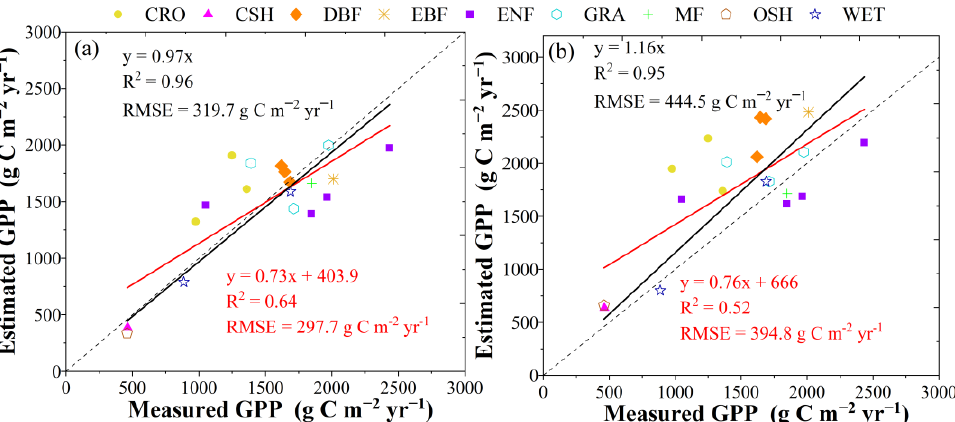
Figure 2. Validation of model-estimated annual total GPP (g C m −2 yr −1 ) and GPP derived from EC data for the 19 EuroFLUX sites selected for independent model validation (Table 1). GPP values estimated using the FGM were parameterized with ( a ) LCC-derived V cmax and ( b ) TRY-based V cmax . The R 2 and RMSE were estimated from the regression lines for the modeled GPP and EC-GPP. The black solid lines and the red solid lines are the regression lines with the intercept forced to 0 or not, respectively.